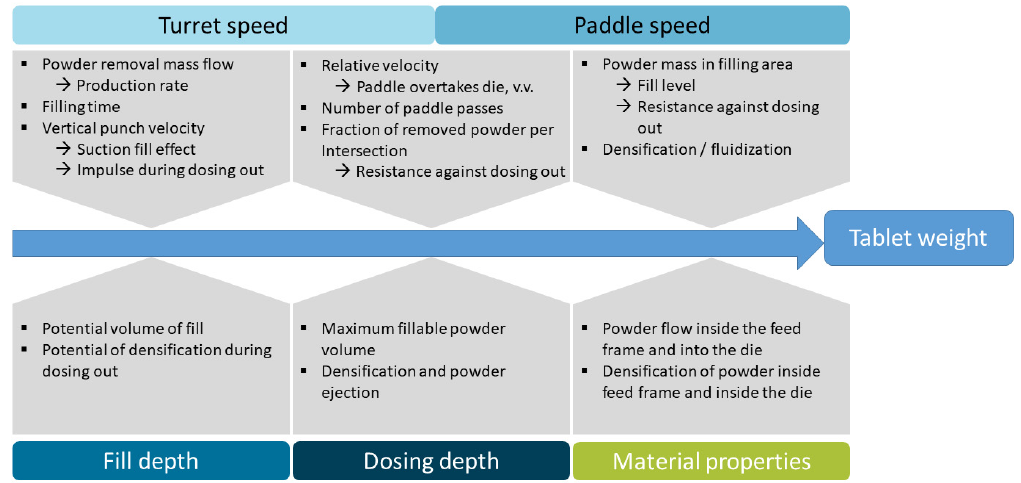
Figure 4. Summarized influences of process parameters and material properties on the tablet weight during die filling.